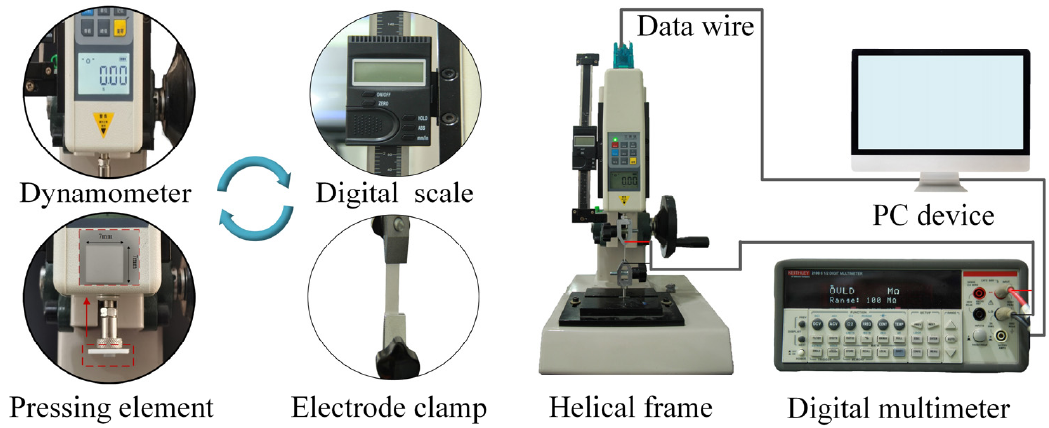
Figure 2. Schematic diagram of a test platform for resistive strain and pressure sensor.